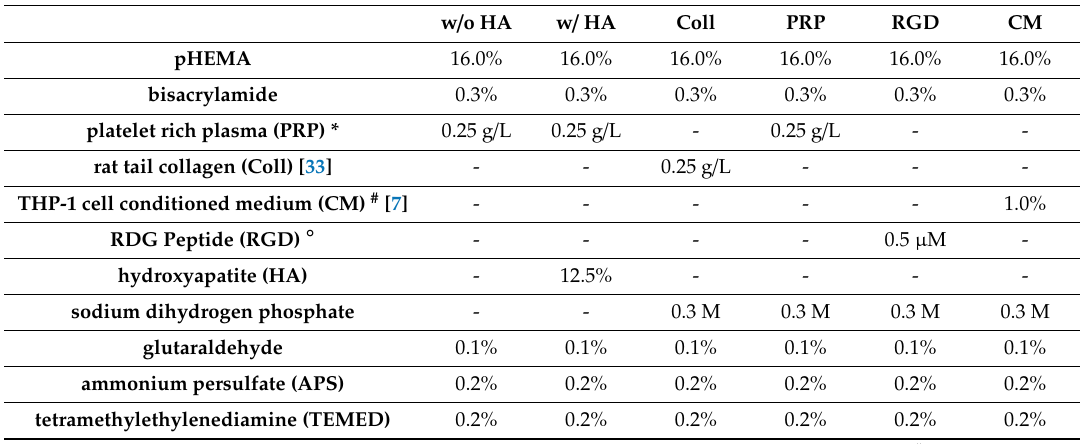
Table 1. Composition of the di ff erent cryogel-sca ff olds. Final concentrations are given (ddH 2 O was used to adjust the